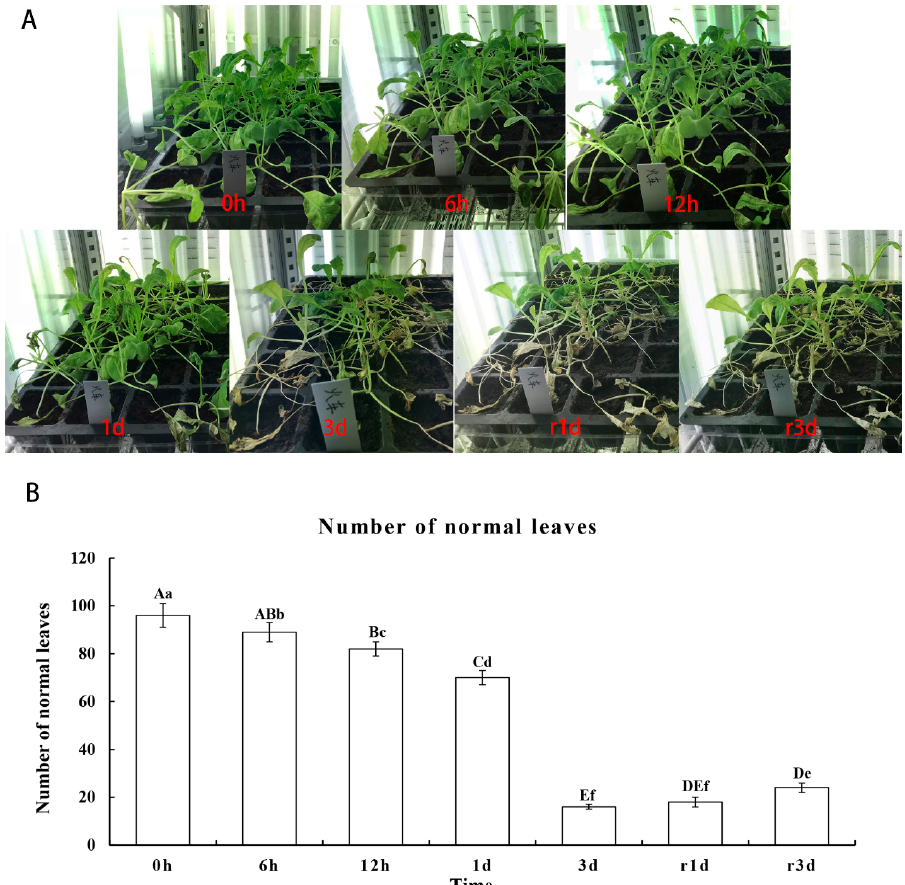
Figure 1. Morphological changes and normal leaf number of radish seedlings under heat stress and recovery treatment. ( A ) The radish seedlings under heat shock for 0 h, 6 h, 12 h, 1 d and 3 d as well as under recovery treatment for 1 d and 3 d. ( B ) The number of normal leaves in “Huoche” under heat shock for 0 h, 6 h, 12 h, 1 d and 3 d as well as under recovery treatment for 1 d and 3 d. Bars with different letters above the columns of figures indicate significant differences at p less than 0.05 (lowercase letters) or less than 0.01 (capital letters).